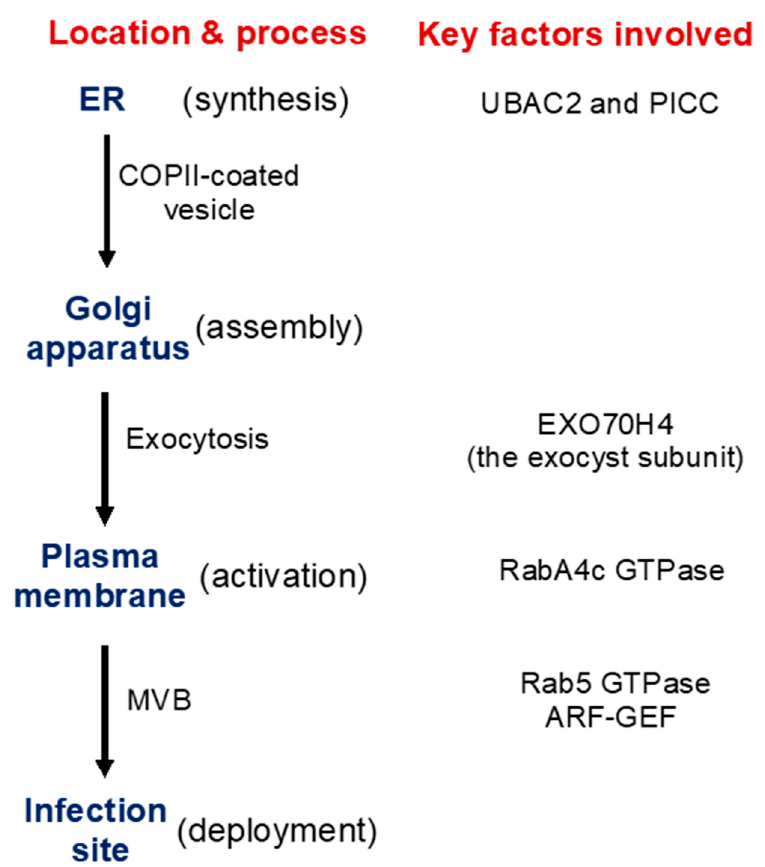
Figure 2. Synthesis, transport, activation, and recruitment of Arabidopsis PMR4 callose synthase during plant defense responses. Some of the important factors identified to be involved in these processes are indicated.